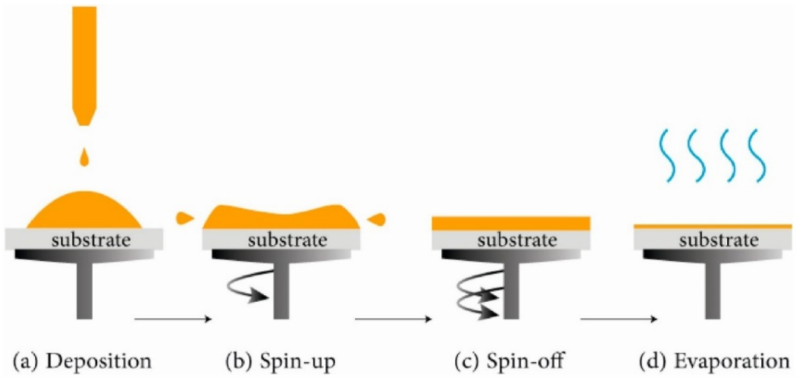
Figure 9. The four basic stages of spin coating: ( a ) deposition, ( b ) spin-up, ( c ) spin-off, and ( d ) evapo- ration. Reprinted with permission from